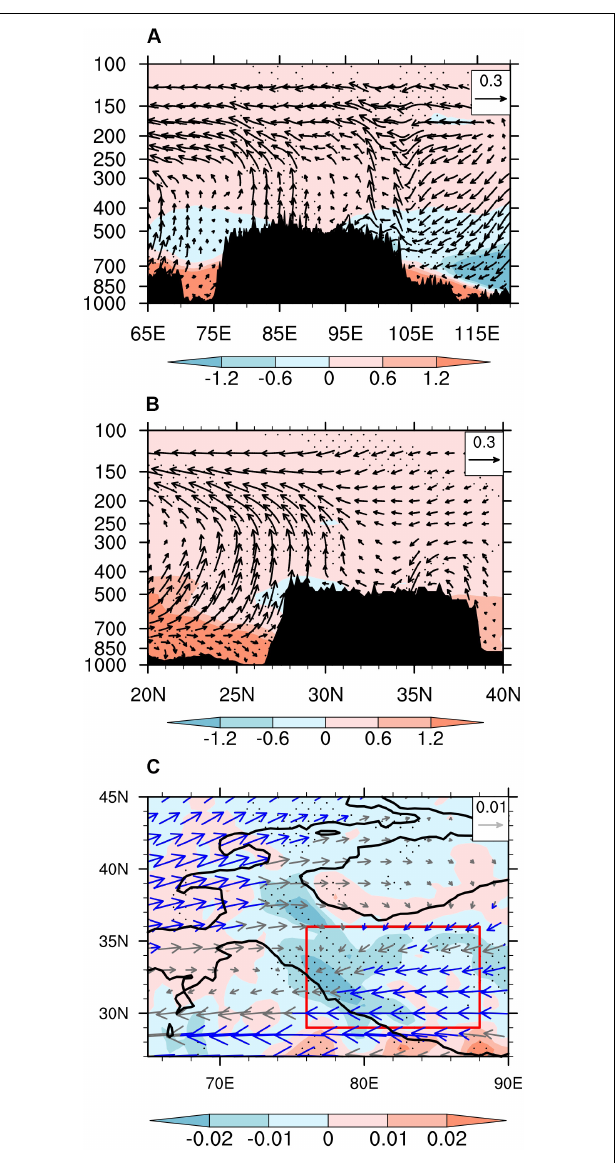
FIGURE 7 | Regression fields of the (A) cross sections of zonal-vertical circulation (vectors; zonal wind speed in m/s, and vertical velocity in Pa/s, multiplied by − 57) and specific humidity (shaded; units: 10 − 2 g/kg) averaged over 25 ◦ –32 ◦ N, and (B) cross sections of meridional-vertical circulation (vectors; zonal wind speed in m/s, and vertical velocity in Pa/s, multiplied by − 71) and specific humidity (shaded; units: 10 − 2 g/kg) averaged over 80 ◦ –88 ◦ E, and (C) water vapor flux (vectors; units: g/cm • s • hPa) and convergence at 400 hPa (shaded; units: 10 − 8 g/cm 2 • s • hPa), against the BSICI. The vectors of the stippled areas in A and B exceed the p = 0.1 confidence level. Blue arrows in C indicate vector values above the p = 0.1 confidence level. The red box in C represents the MWTP region. The black line over the region (25 ◦ –45 ◦ N, 60 ◦ –110 ◦ E) in C outlines the 2-km topography of the Tibetan